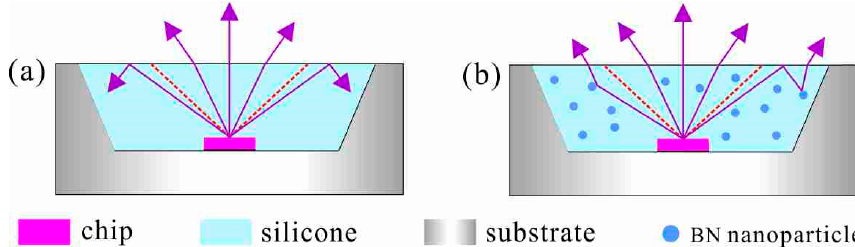
Figure 7. Schematic diagram of the UVLED ( a ) without BN or ( b ) with BN NPs. Dotted red lines indicate the incidence angle for total reflection.